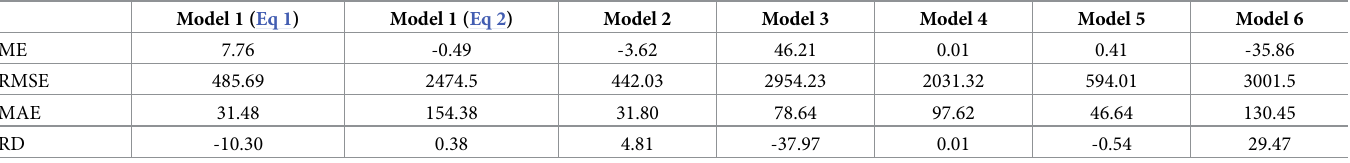
Table 5. Findings from model validation